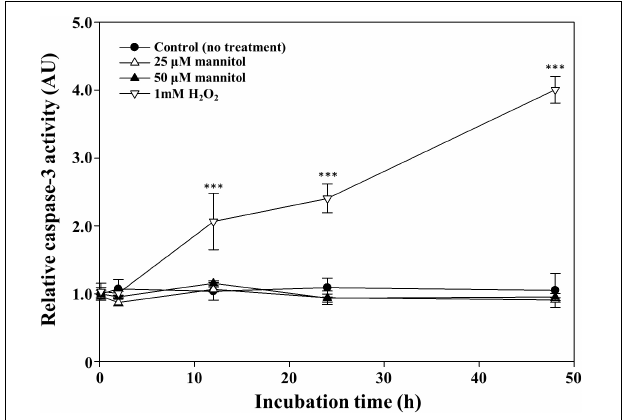
FIGURE 4 | Time course caspase-3 (-like) activity of Microcystis aeruginosa NIES-298 cells treated with mannitol and H 2 O 2 (as a positive control agent). The caspase activities were expressed as arbitrary unit (AU). Data are indicated as mean values ± standard deviations. Statistical significances depending on the treatments were calculated compared to the control group (no treatment) and their significant differences were indicated with p -values < 0.001 ( ∗∗∗